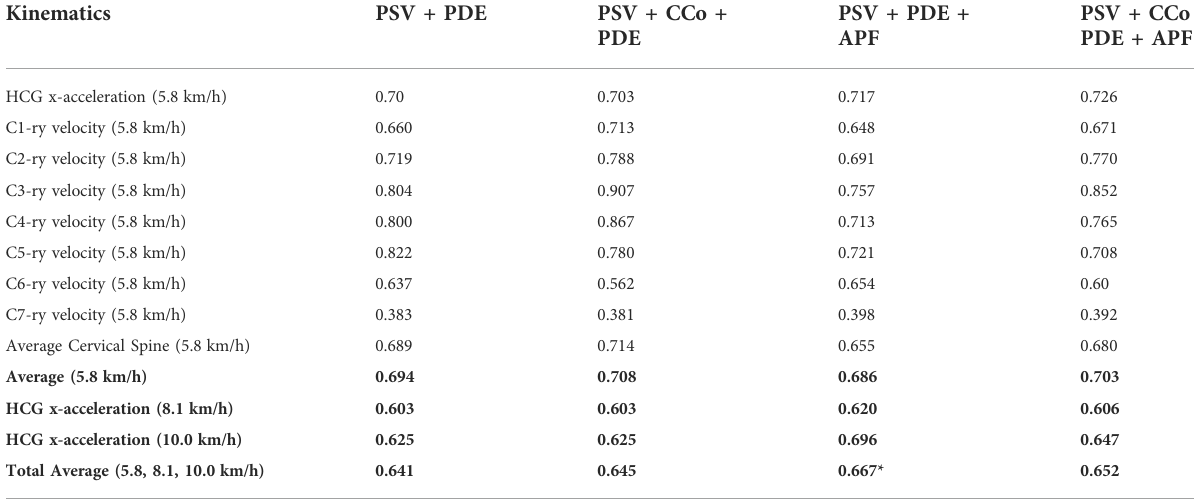
TABLE 6 CORA score of female head-neck model injury criteria input. Kinematics